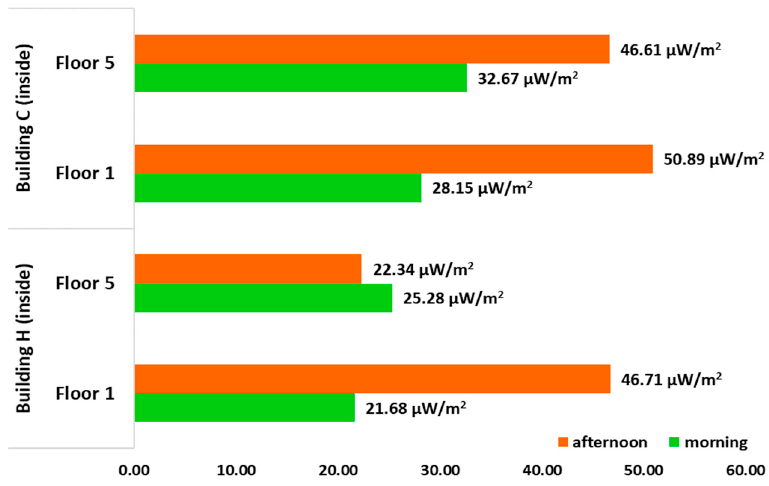
Figure 13. Wi-Fi exposure of RF-EMF from the mean contributions inside building H and C, indicating afternoon and morning ( μ W/m 2 ).